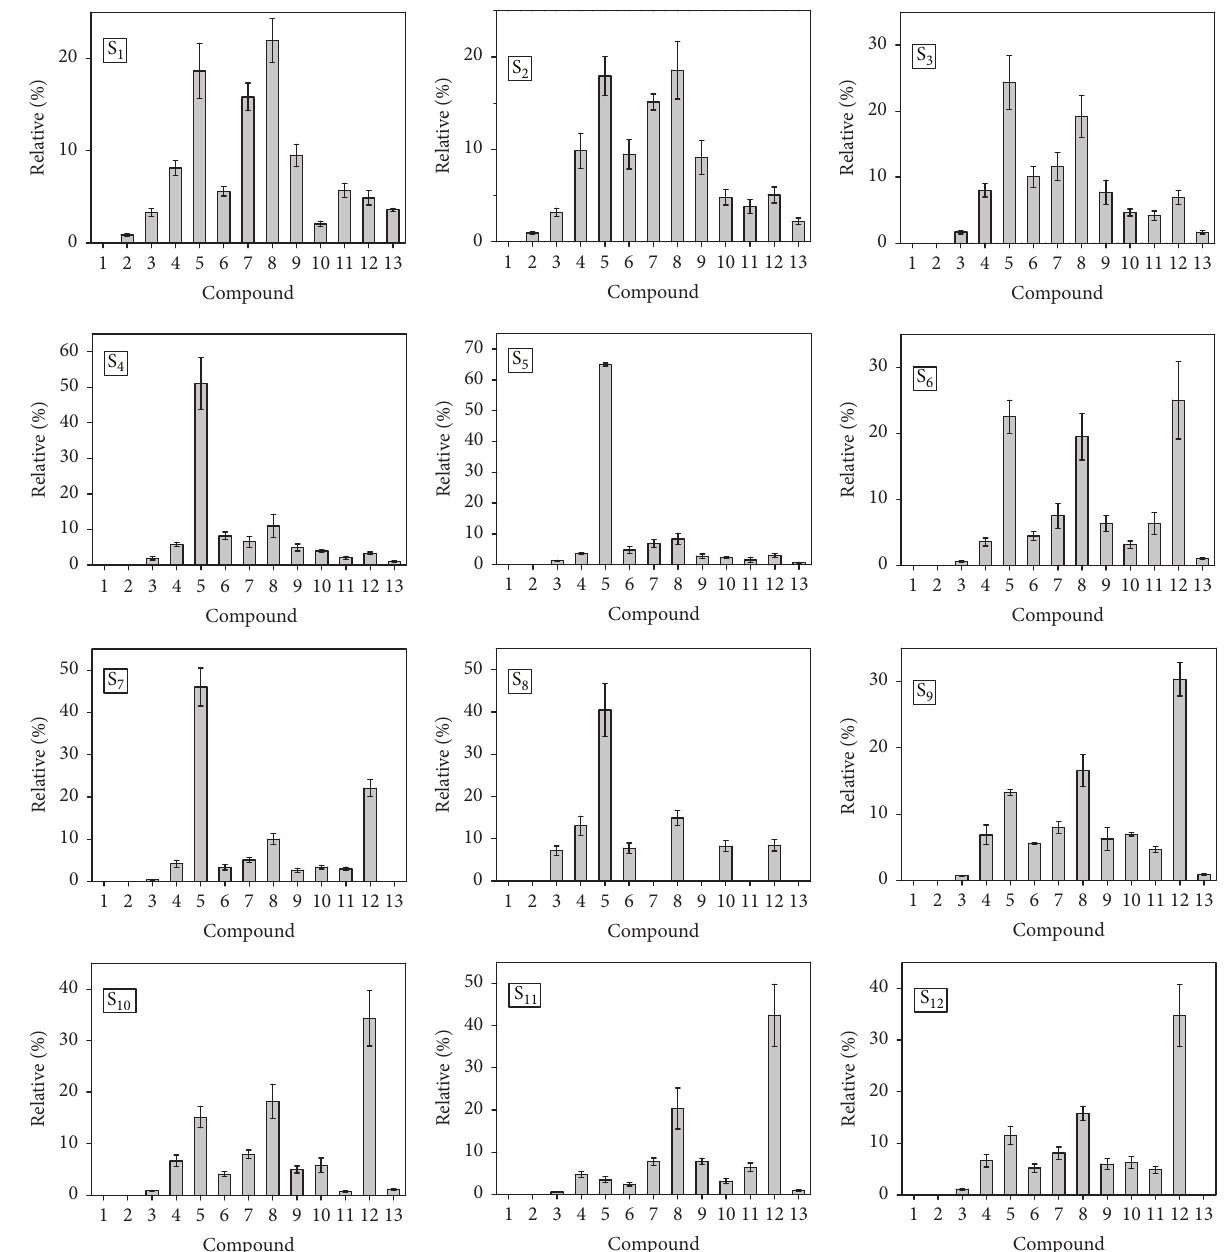
Figure 3: Relative distribution of sterols and triterpenols in sedimentary core samples at 0–2 cm from Canan´eia-Iguape estuarine-lagoonal system, as revealed by UHPLC-MS/MS. (1) Ergosterol, (2) epicoprostanol, (3) coprostanol, (4) cholestanol, (5) cholesterol, (6)